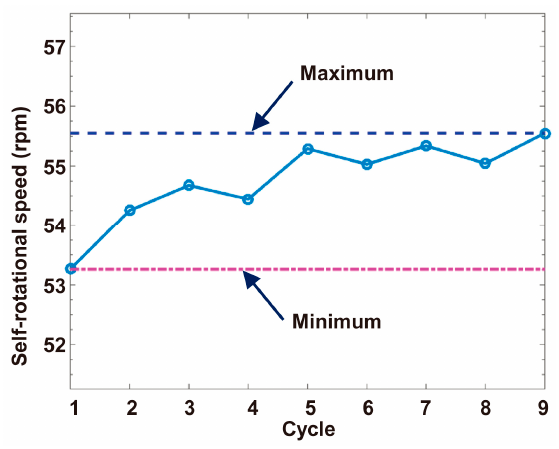
Figure 12. Average self-rotational speed in each cycle.